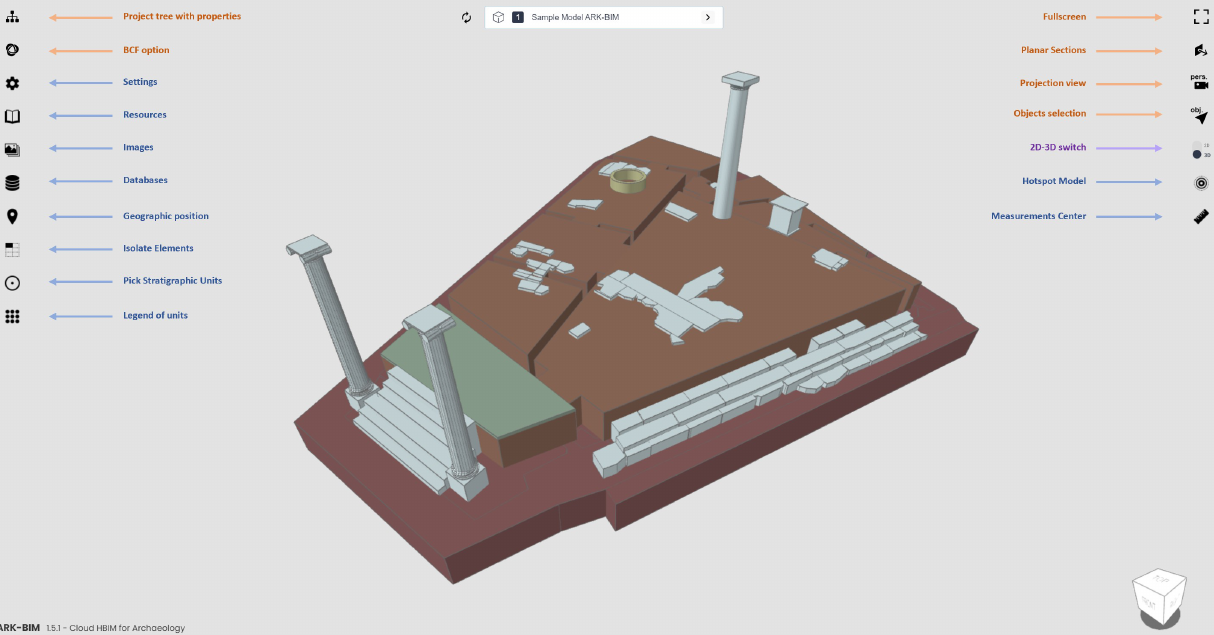
Figure 8. ARK-BIM (version 1.5.1) interface: BIMData default plugins (in orange); unlocked plugins (in purple); new plugins (in blue).